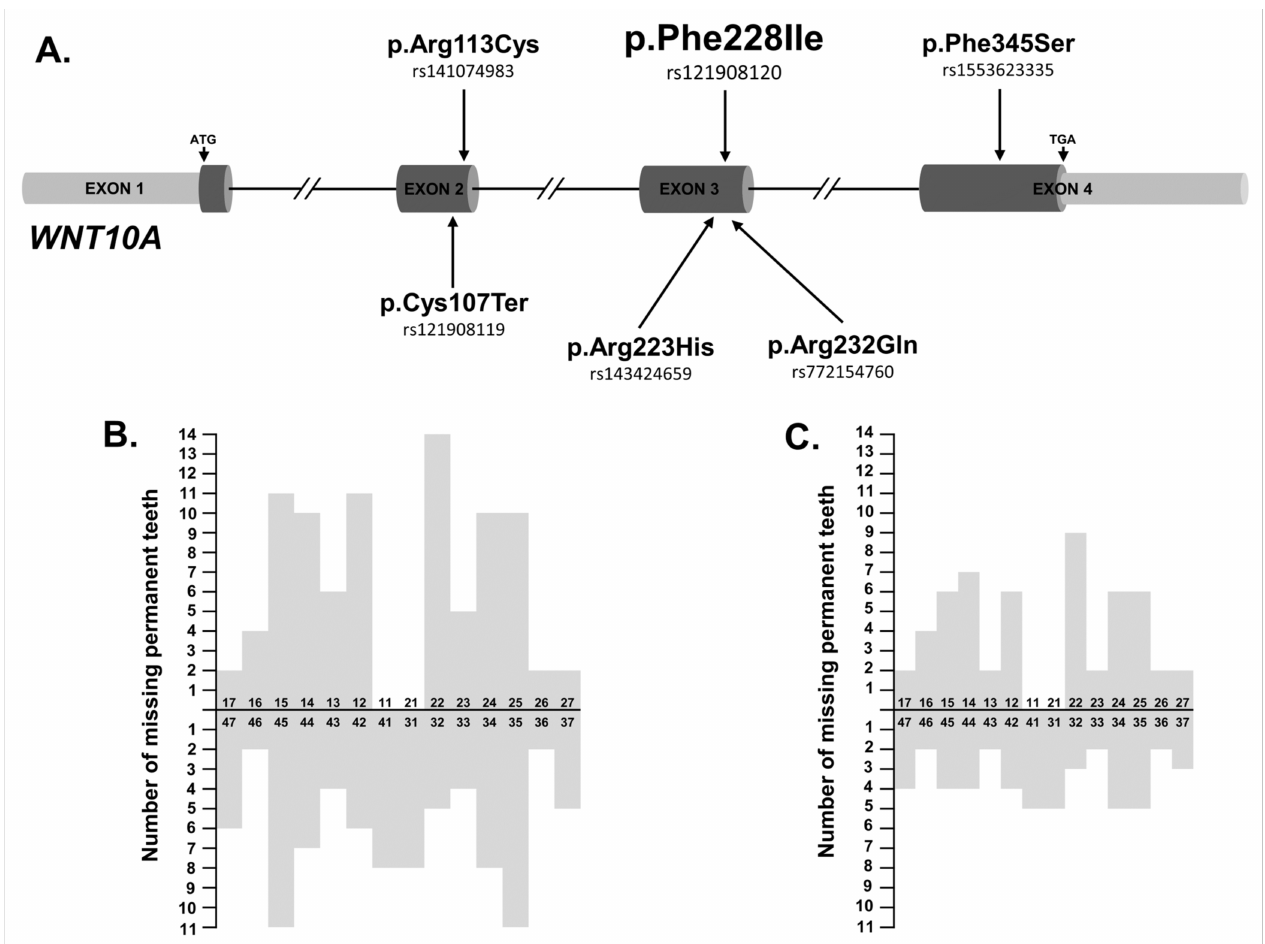
Figure 1. ( A ) Distribution of WNT10A nucleotide variants identified in ns-TA patients. ( B ) Number of missing permanent teeth in 18 patients with identified WNT10 nucleotide variant/variants ( n = 174, the mean number of missing permanent teeth per person, excluding third molars = 9.67,